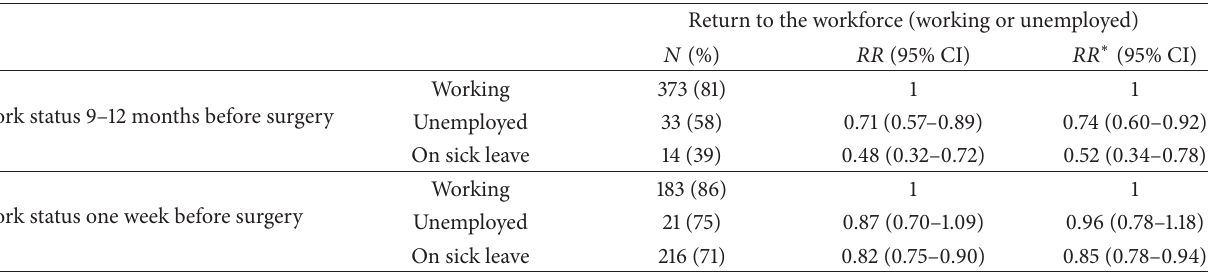
Adjusted for age, gender, type of operation, and